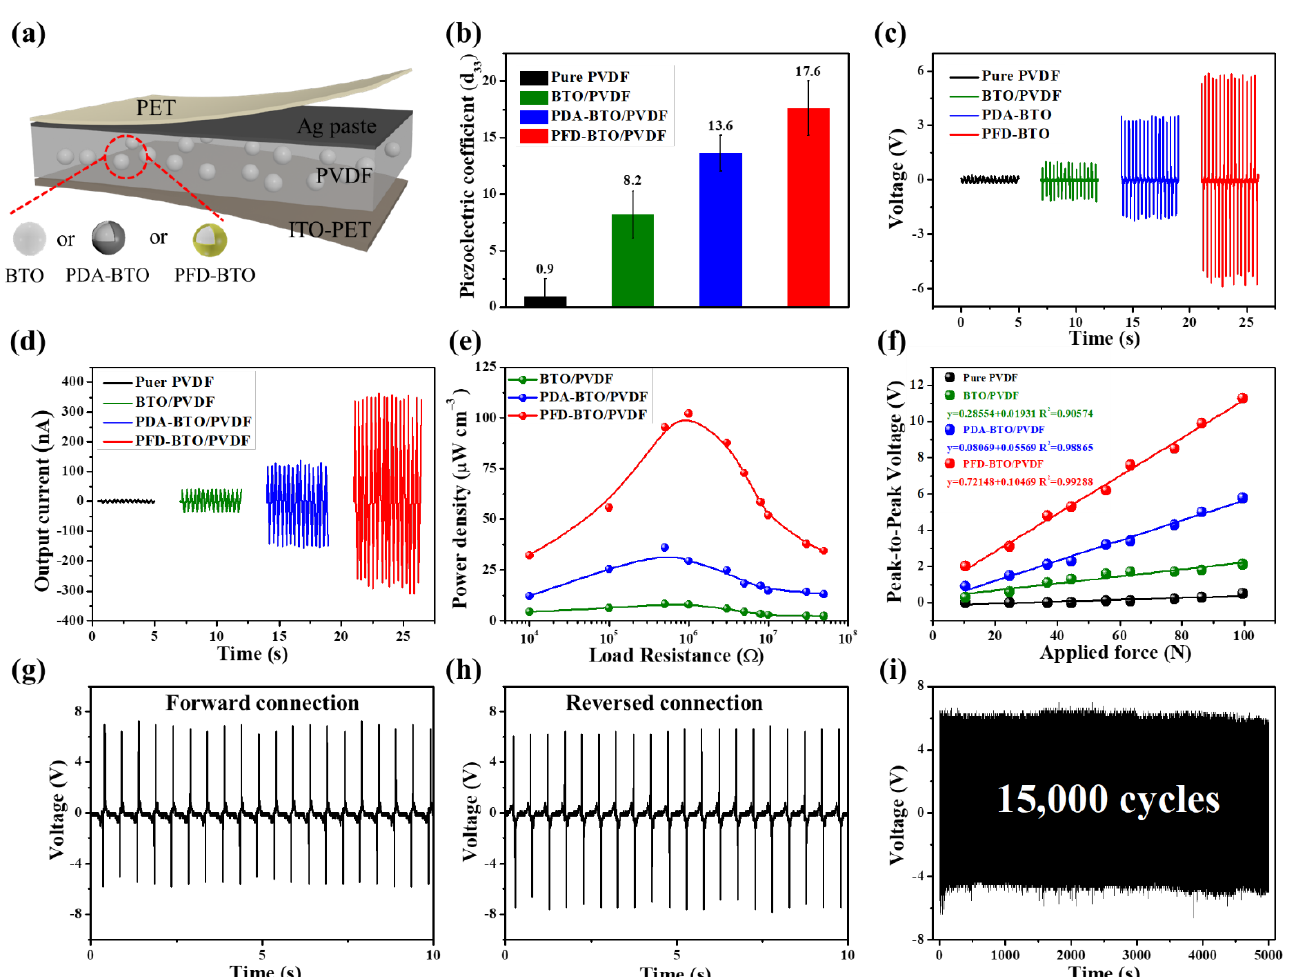
Figure 7. ( a ) Schematic structure of the printed PENGs. ( b ) Piezoelectric coefficient (d 33 ) of PVDF-based films with 8 wt% filler content of the BTO, PDA-BTO or PFD-BTO NPs. ( c ) Output voltages and ( d ) output current of all as-printed PENGs under periodic impact force with 100 N at 3 Hz. ( e ) Dependence output power density of all as-printed PENGs on load resistance. ( f ) Dependence of voltage of all as-printed PENGs on the different applied force. Output voltage signals from ( g ) forward-connected and ( h ) reverse-connected circuits. ( i ) Voltage recorded of the PFD-BTO/PVDF-based PENG at 100 N of 3 Hz for 15,000 cycles.